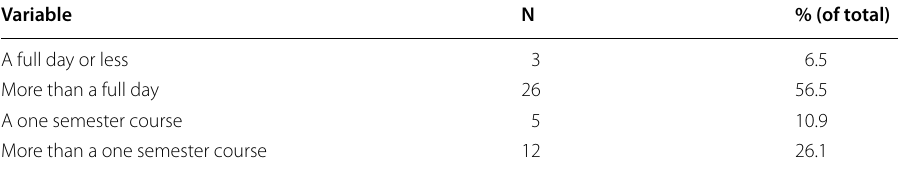
Table 7 Academics’ perceptions of the total amount of professional development they need